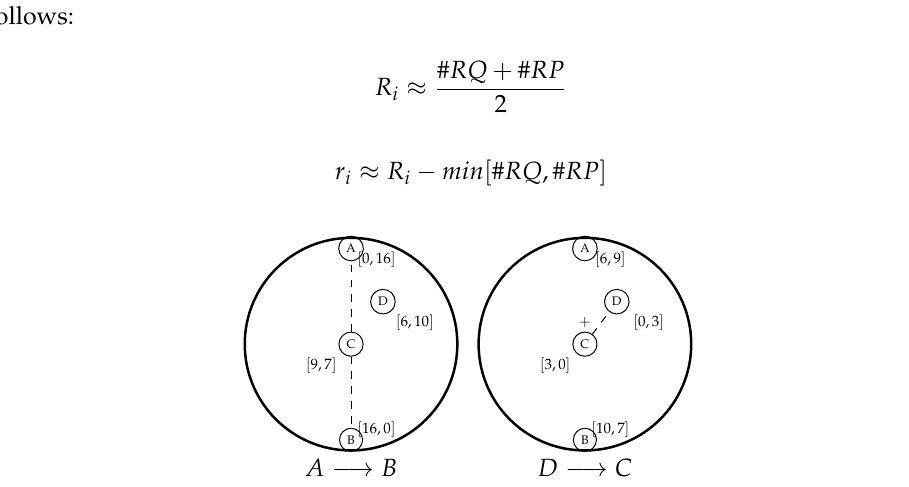
Figure 7. Estimating the repeal-flooding